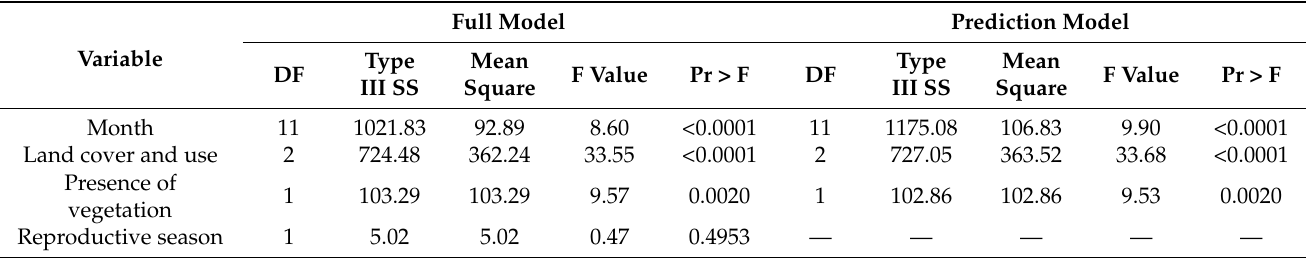
Table 2. General Linear Models examining the relationship between the number of individuals from each bird species found in Annaba, Algeria during 2017–2018 and the variables with a potential influence on it.